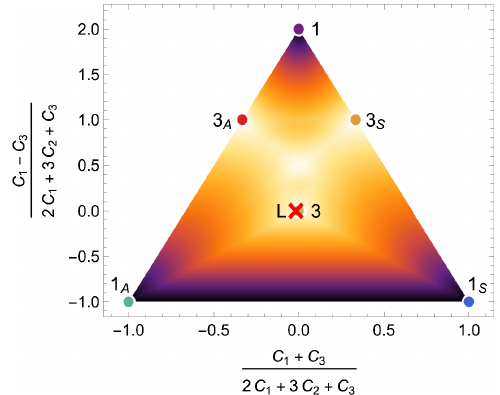
Figure 18. The cross section of the positivity cone for Higgs operators, together with the 6 tree- level generators and the loop-level generator, ~g , given in eq. (6.26). The latter is represented by loop a red cross labeled with “L”, and is very close to the ~g generator. The degeneracy is also shown, 3 but is only computed with tree-level generators, and is the same as in figure 11.